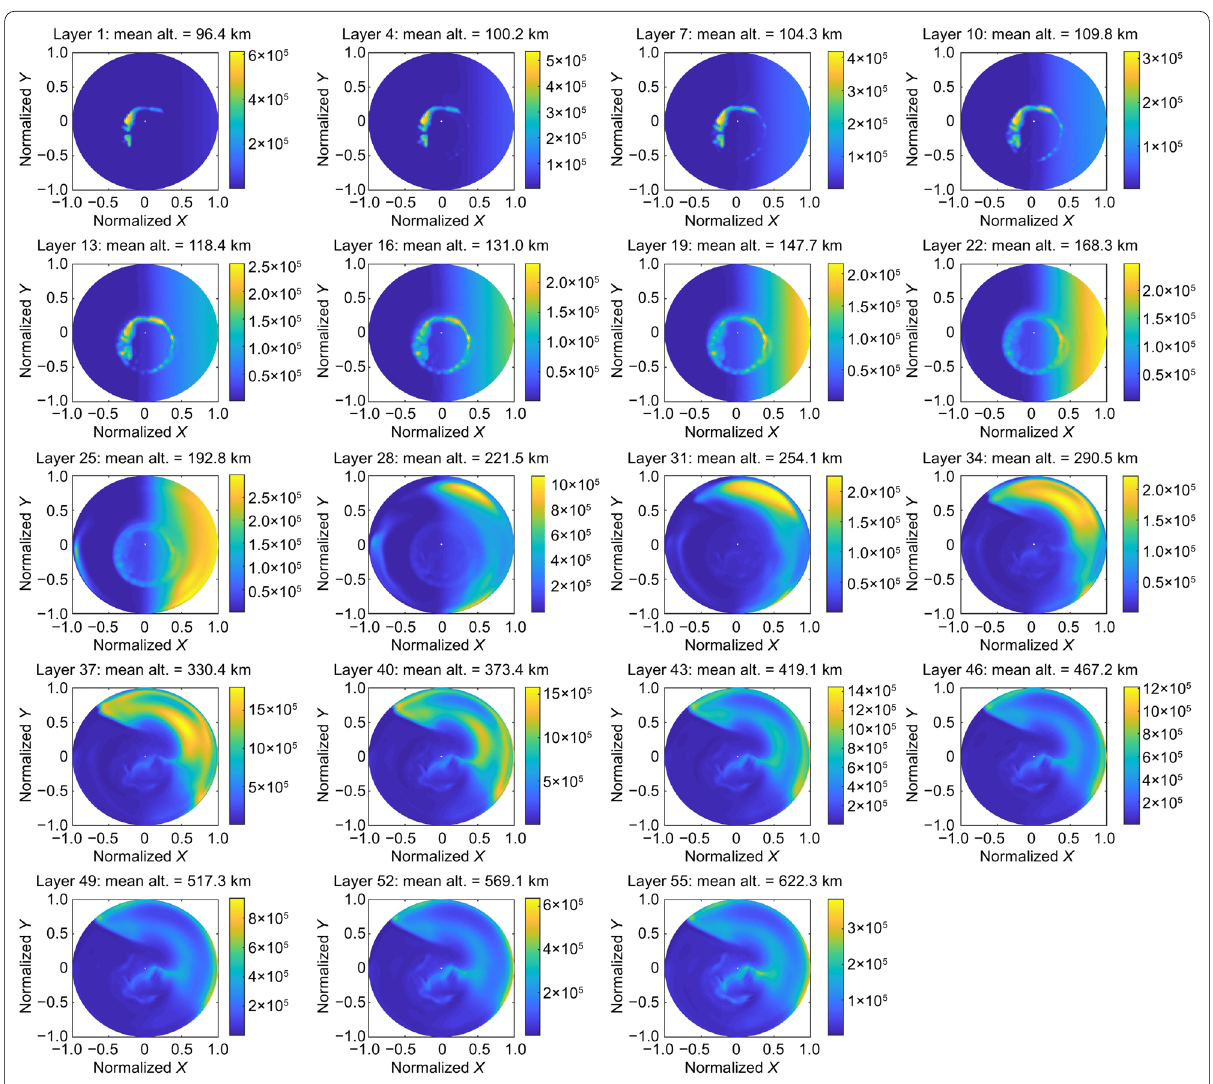
Fig. 16 Northern hemisphere’s electron density profile at multiple TIEGCM height layers 12:00:00 UTC on March 17, 2013). (Adapted from